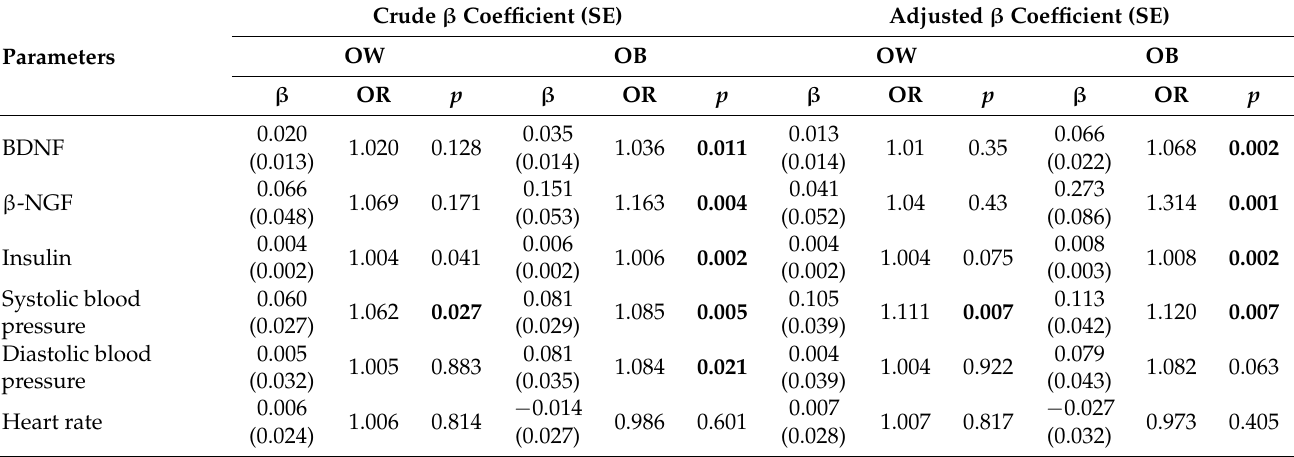
Table 1. Odds ratios of multinominal regression analysis adjusted for age, gender, income, and maternal education (Reference category: